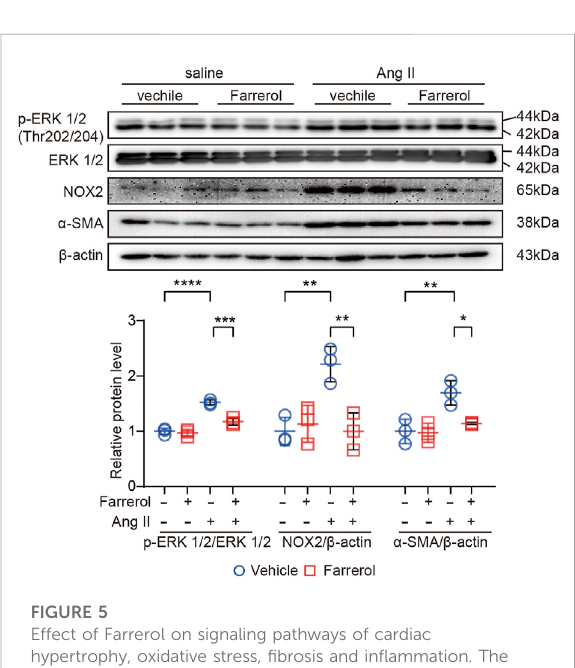
FIGURE 5 Effect of Farrerol on signaling pathways of cardiac hypertrophy, oxidative stress, fi brosis and in fl ammation. The proteinexpressionofp-ERK(The202/204),ERK,NOX2, α -SMAand β -actin in the heart of each group of mice, and the relative valueofthestatisticalchart(Salline =3,Farrerol=3,AngII=3,Ang II + Farrerol =